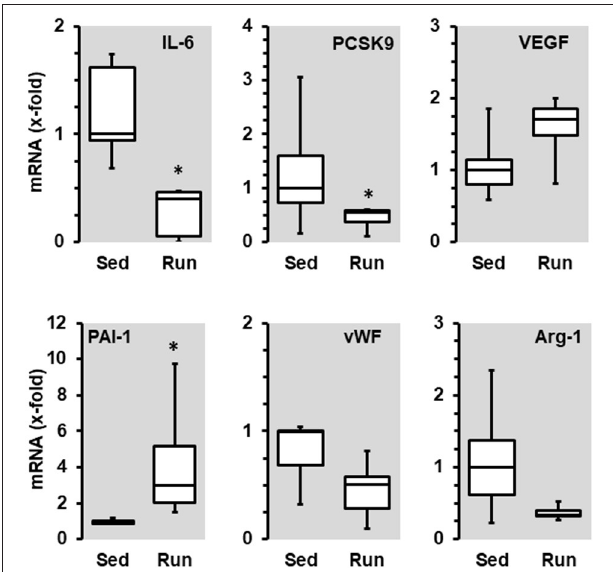
FIGURE 3 | Effect of 10 months voluntary running wheel activity (Run) on mRNA expression of selected genes in normotensive rats compared to sedentary controls (Sed). Selection criteria are differences in median expression of more than 50% or p -values below 0.05. Box plots represent 25, 50, and 75 percentiles with 5 and 95 percentiles given as whiskers. * p < 0.05; unpaired T -Test.